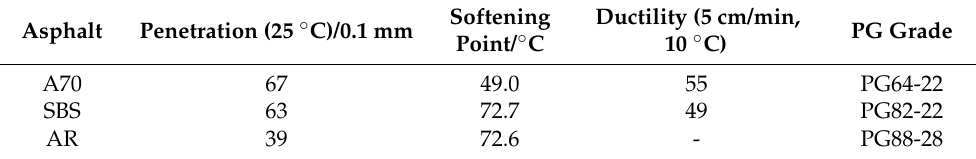
Table 1. Basic technical indices of asphalt.